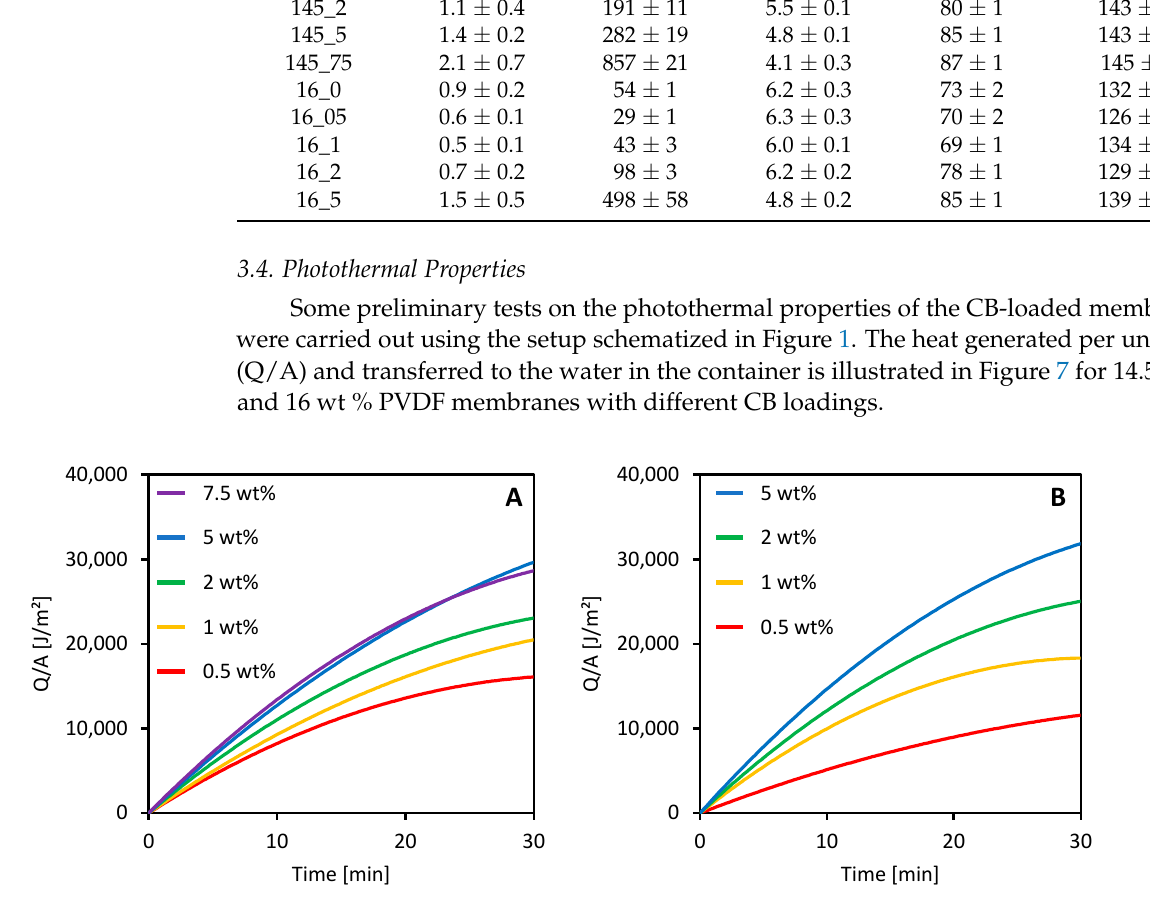
Figure 8. Mean distillate fluxes obtained with CB-loaded membranes using ( A ) pure H 2 O and ( B ) a 90 g/L NaCl solution as feed.